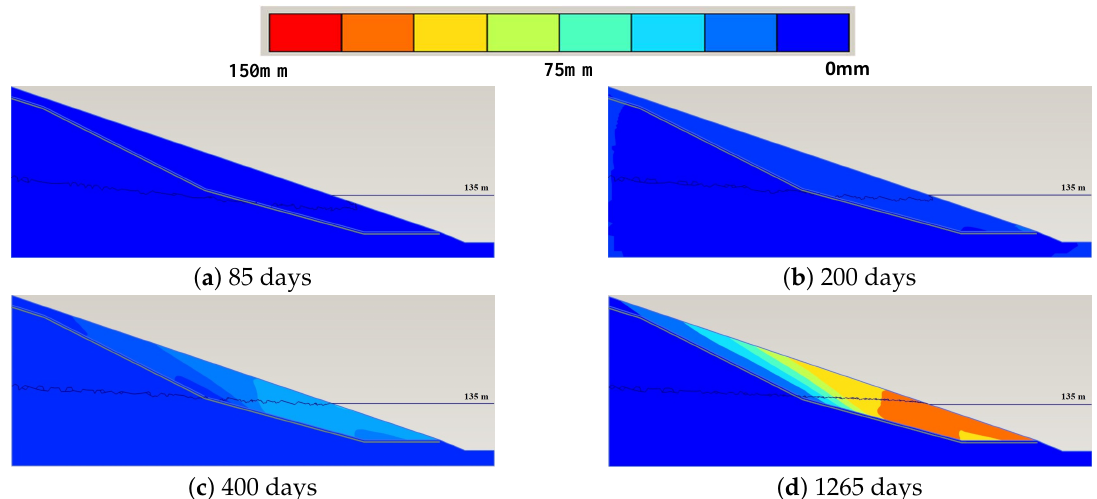
Figure 5. Evolution of the horizontal displacement at different time steps after the river level starts rising.